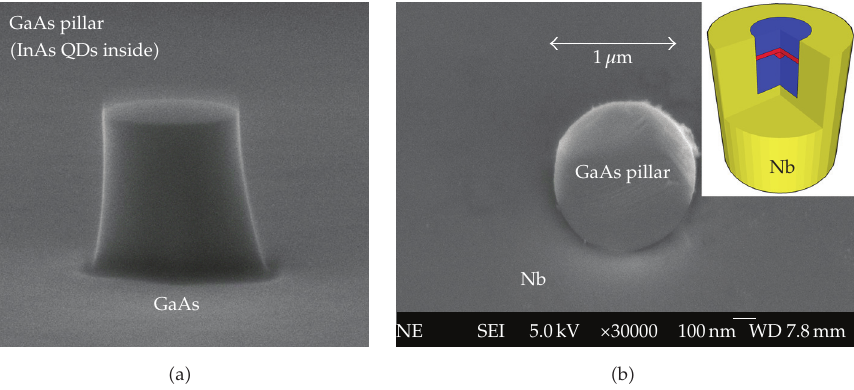
Figure 9: (cid:5) a (cid:6) SEM images of conventional GaAs pillar structure. InAs QDs are inside the pillar. (cid:5) b (cid:6) Top view of GaAs pillar after the Nb embedding. Schematic drawing of the Nb-embedded pillar structure is shown in the